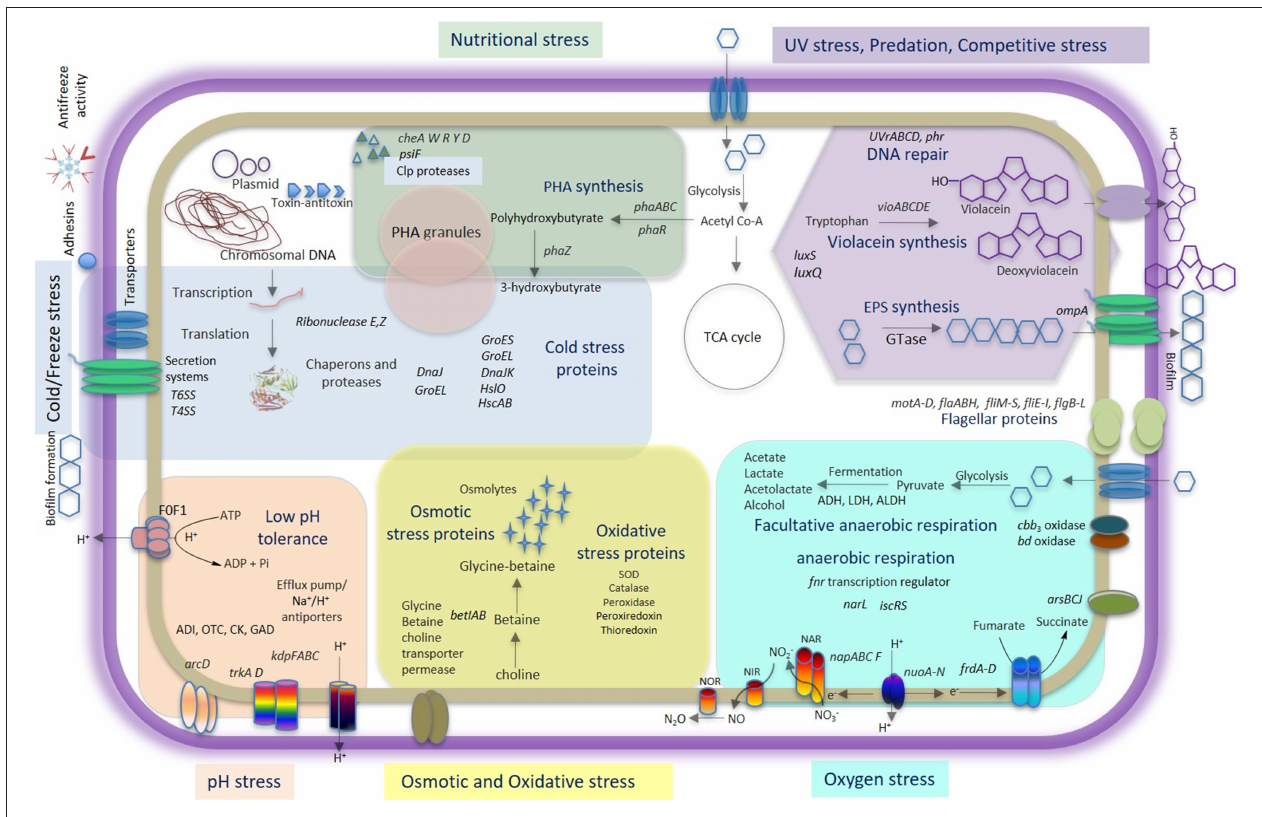
FIGURE 6 | Comprehensive model of Iodobacter sp. PCH194 adaptive strategies. The model is based on genomic, proteomic, and physiological data showing multiple strategies of Iodobacter sp. PCH194 to adapt to the predominantly frozen kettle lake environment in the high-altitude